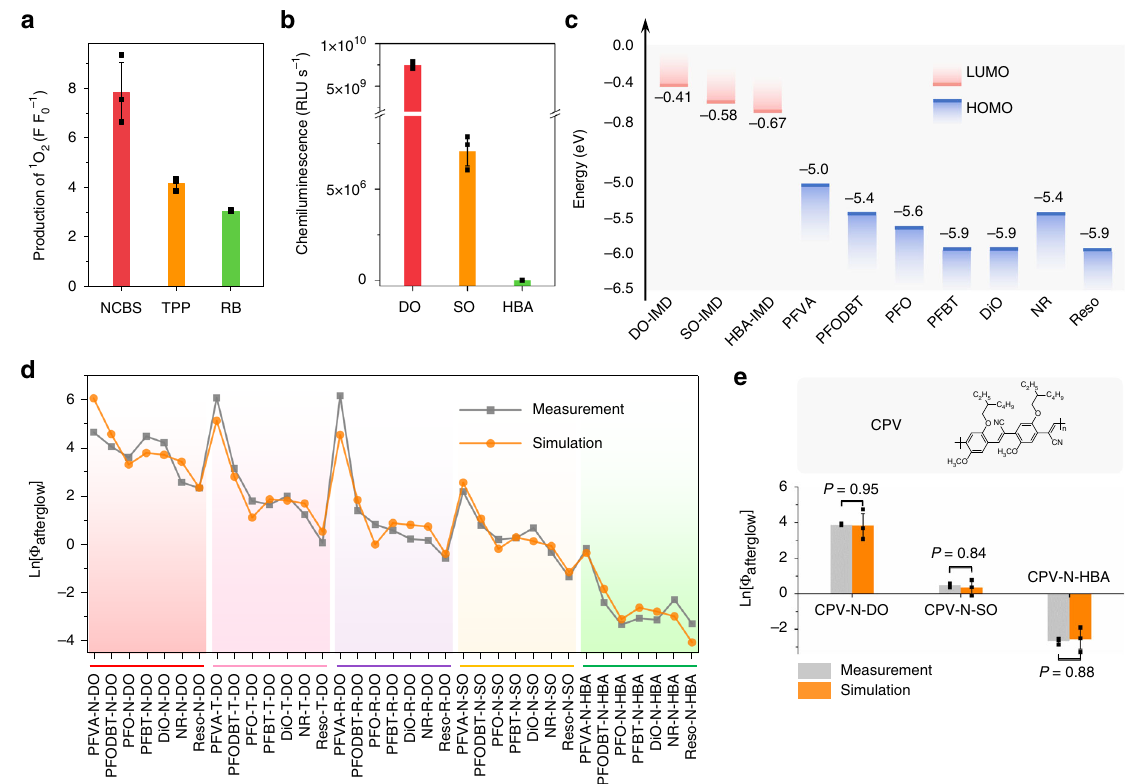
Fig. 3 Mechanistic study of descriptors in the estimation of afterglow intensity of ALNPs. a Quanti fi cation of 1 O 2 generating capability for the different afterglow initiator doped nanoparticles at identical mass concentration (0.75 μ g mL − 1 ) in 1 × PBS (pH = 7.4). NCBS nanoparticles were pre-irradiated at 808 nm for 5 s (at 1 W cm − 2 ), while TPP and RB nanoparticles were pre-irradiated with white light for 5 s (0.1 W cm − 2 ). Production of 1 O 2 was de fi ned as the fl uorescence enhancement ( F F 0 − 1 ) of 1 O 2 sensor green (SOSG, 1 μ M) at 524 nm. b Chemiluminescent intensities (RLU s − 1 ) of DO, SO, and HBA in the presence of NCBS in tetrahydrofuran after pre-irradiation at 808 nm for 5 s (at 1 W cm − 2 ). [DO] = [SO] = [HBA] = 15 μ g mL − 1 ; [NCBS] = 0.75 μ g mL − 1 . RLU, relative light unit. c Schematic illustration of energy levels of afterglow substrates and afterglow relay units 39,47,48 . LUMO, lowest unoccupied molecular orbitals. DO/SO/HBA-IMD, DO/SO/HBA-based dioxetane intermediate. d Measured (measurement) and estimated (simulation) afterglow intensities of ALNPs. Estimated afterglow intensities were calculated from Eq. (1). e Prediction of afterglow intensities of a new afterglow relay unit CPV by Eq. (1). P values were calculated by Student ’ s two-sided t -test. Inset: chemical structure of CPV. Error bars indicated standard deviations of three separate